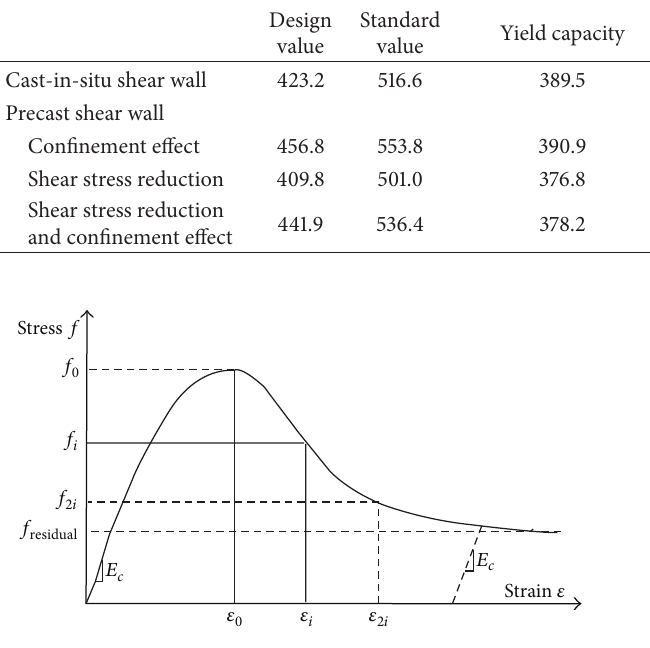
Figure 9: The stress-strain curve of confined concrete.